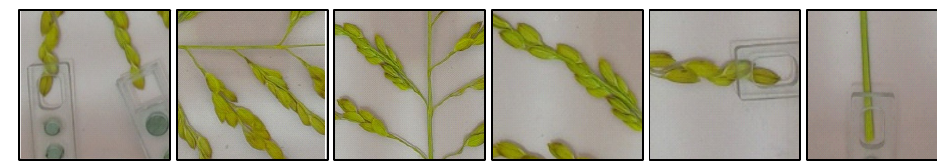
Figure 4. Image labeling.